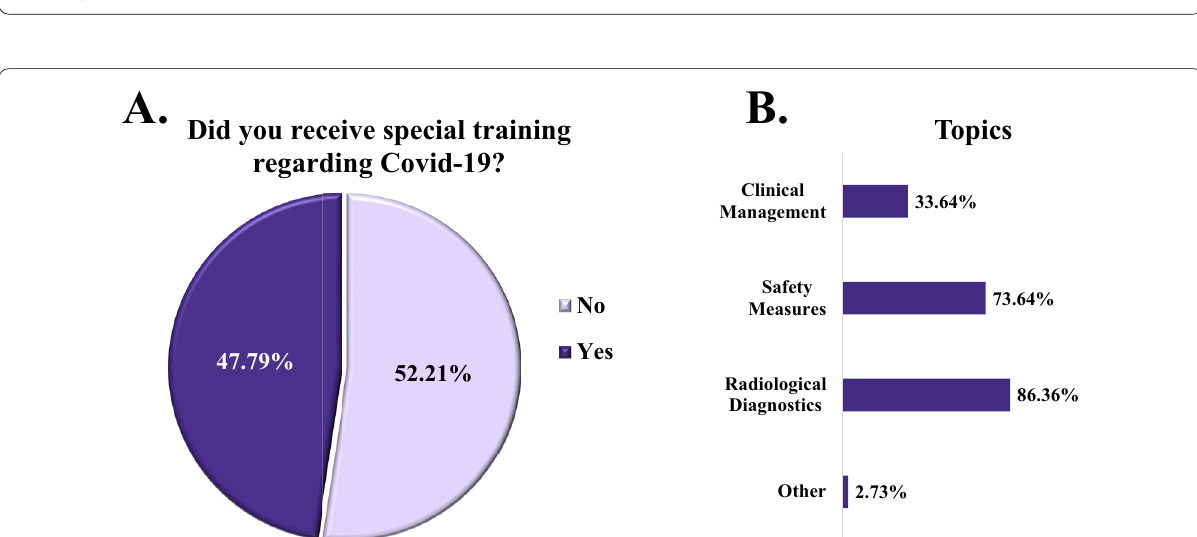
Fig. 3 Responses to questions aiming to collect information about the type of training of young radiologists. The questions assessed the level of institution where the participants worked ( A ), the type of radiology training program ( B ), the duration of their training ( C ) and their year of residency ( D )